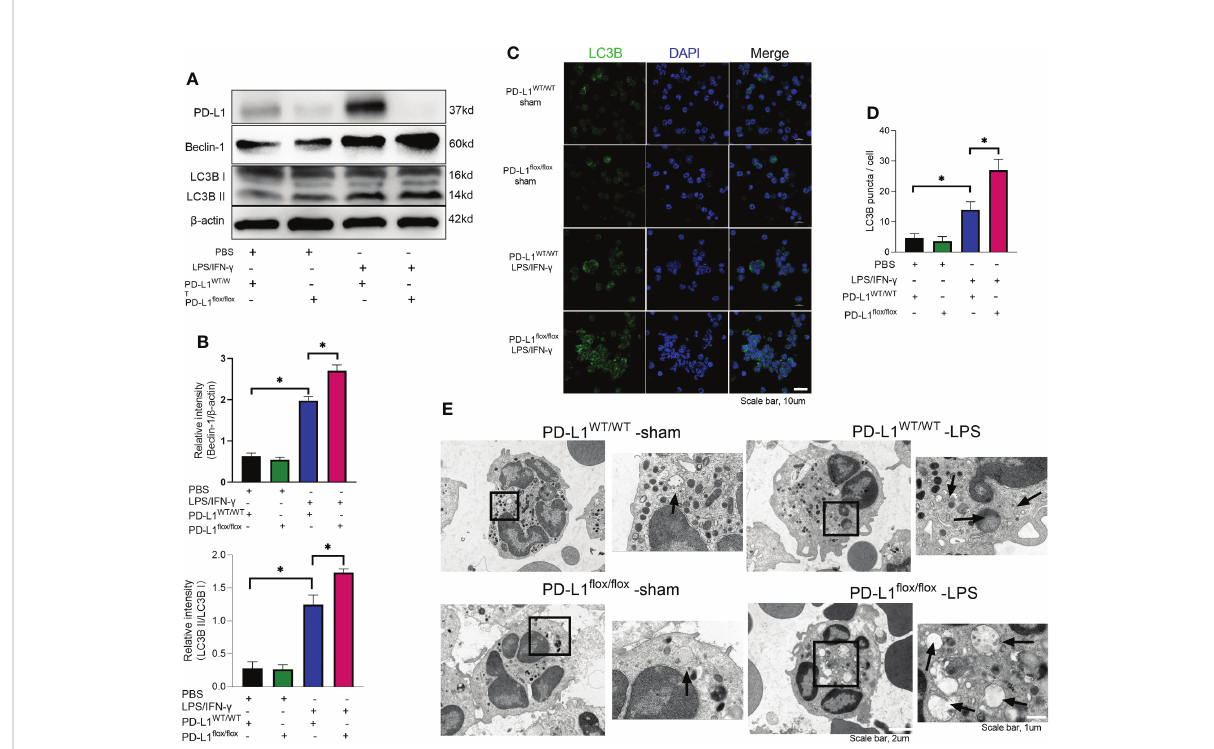
FIGURE 4 Genetic deletion of PD-L1 can increase autophagy levels. (A – D) Neutrophils from PD-L1WT/WT mice or PD-L1 fl ox/ fl ox mice are stimulated with IFN- g (10ng/ml) and LPS (1 m g/ml) for 21 hours. (A) PD-L1, Beclin-1 and LC3B II/I immunoblotting in neutrophils. (B) Integrated optical density ratio of LC3B II/LC3B (I) (C) Autophagy induction assessed with LC3B staining (confocal microscopy; green: LC3B; blue: DNA) in neutrophils (scale bar: 10um). (D) LC3B puncta/cell are depicted. (E) PD-L1WT/WT mice and PD-L1 fl ox/ fl ox mice were injected intratracheally with LPS (10mg/kg) for 24h. Representative transmission electron micrographs of neutrophil autophagosomes in BALF (scale bar: 2um, 1um). The values presented are mean ± SEM (n=6; *P<0.05, one-way analysis of